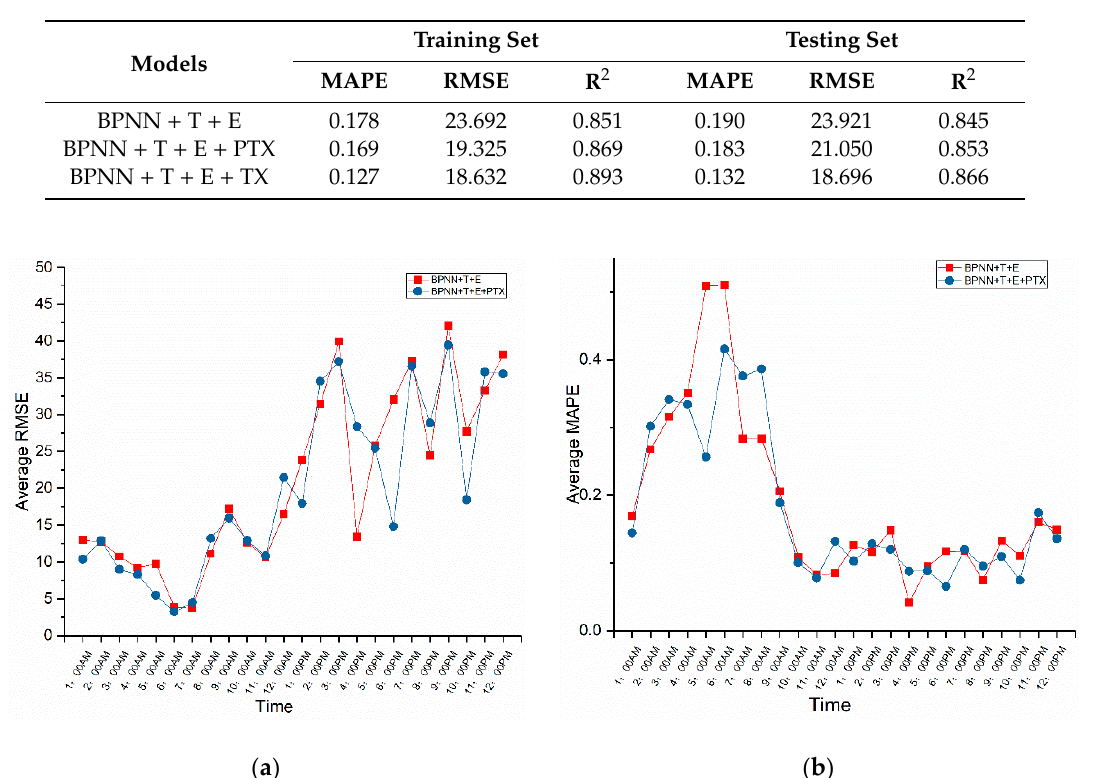
Figure 11. Prediction e ff ects of online taxi-hailing demand predictions in di ff erent hours. ( a ) Average RMSE of online taxi-hailing demand predictions in di ff erent hours; ( b ) Average MAPE of online taxi-hailing demand predictions in di ff erent hours. Table 10. Prediction effects of model “BPNN + T + E”, “BPNN + T + E + PTX” and “BPNN + T + E + TX”.